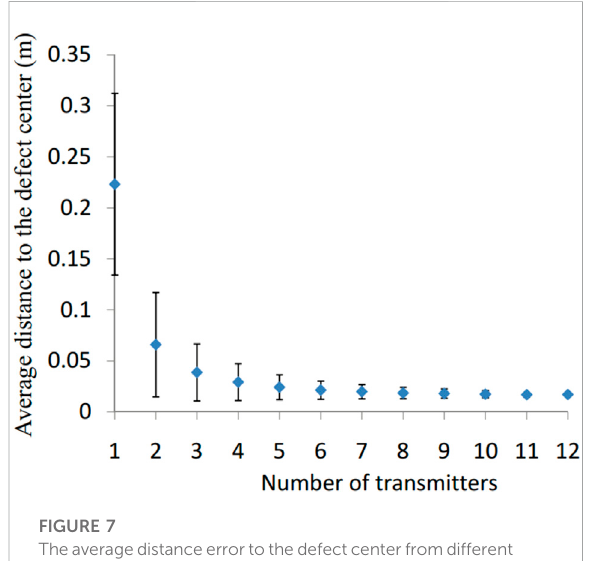
FIGURE 7 Theaveragedistanceerrortothedefectcenterfromdifferent number of transmitters. Error bars represent the standard deviation ranges.